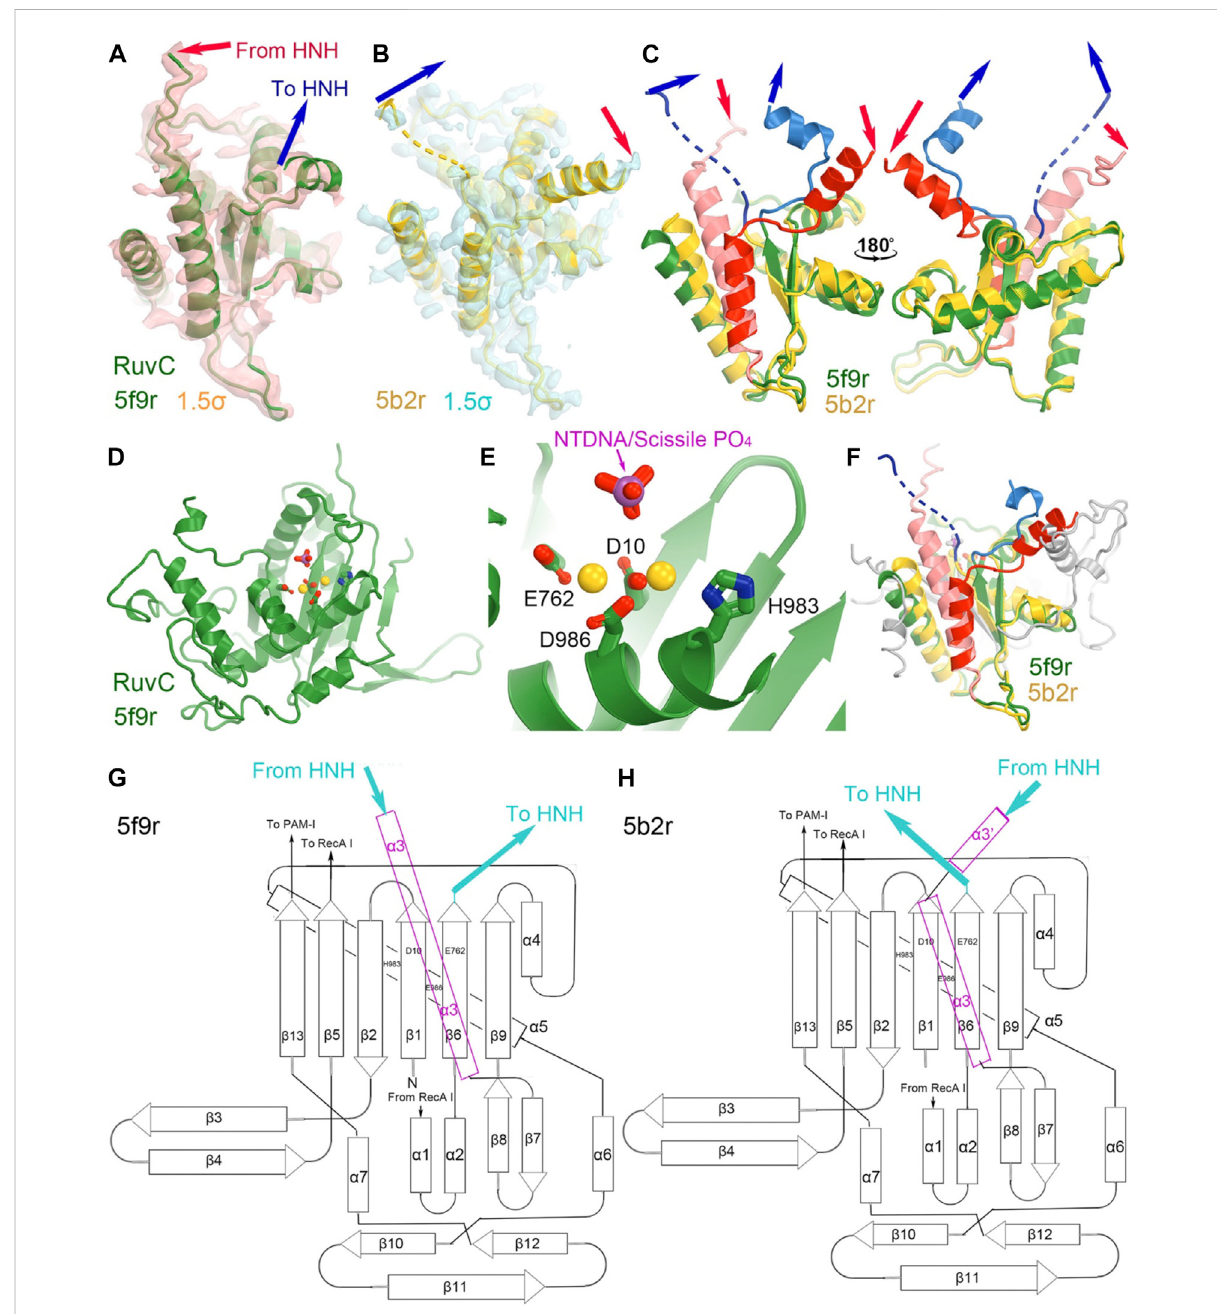
FIGURE 4 Structures of the RuvC domain in the RuvC catalytically relevant (5f9r) and catalytically inactive (5b2r) complexes. (A) Crystallographic electron density maps for a portion of the 5f9r RuvC structure contoured at 1.5 σ . (B) Crystallographic electron density maps for a portion of the 5b2r RuvC structure. (C) Twoviewsofthesuperpositionofpartofthetwostructures. (D,E) AcompleteviewoftheentireRuvCdomainandzoom-inviewofthe RuvC catalytic site, with two metal ions computationally modeled. The ntDNA scissile phosphate is shown in magenta and red. (F) Superimposition of the complete RuvC domains of the two structures with the catalytic residues indicated. (G,H) local topological drawings of the RuvC domain in the two